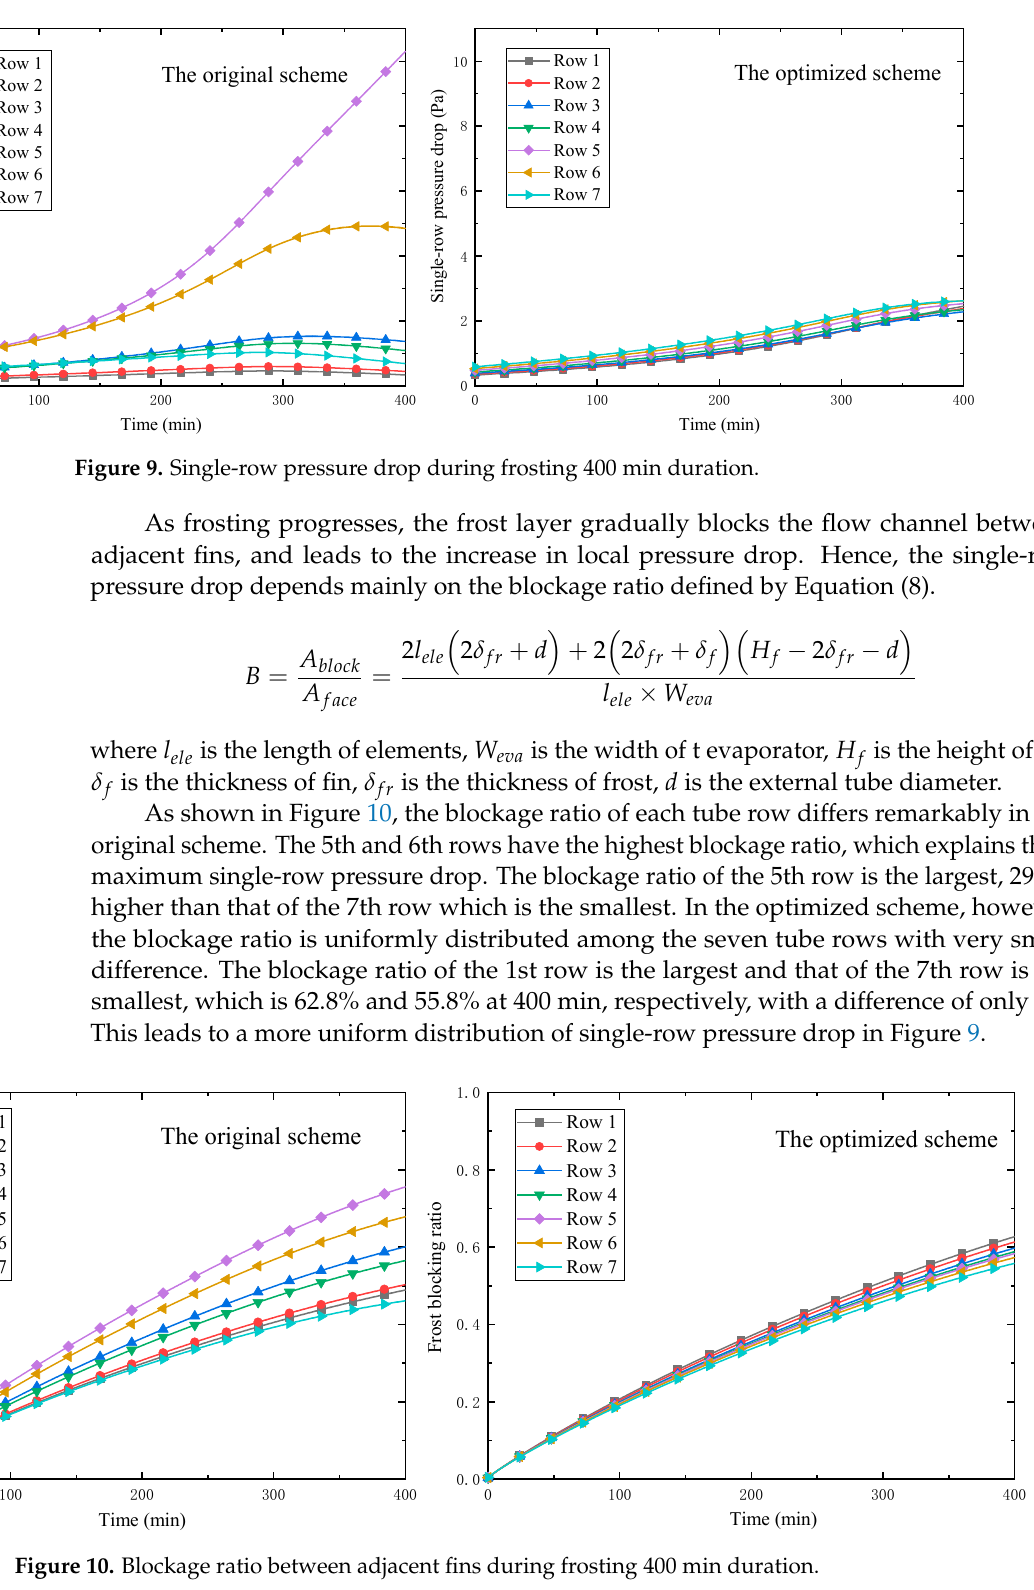
Figure 10. Blockage ratio between adjacent fins during frosting 400 min duration.